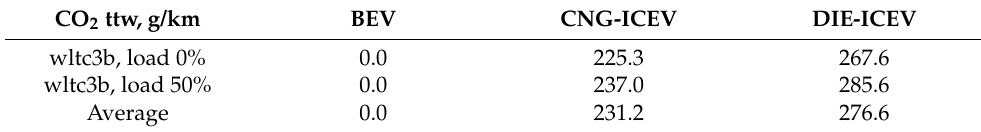
Table A2. Distance-specific TTW CO 2 emissions.